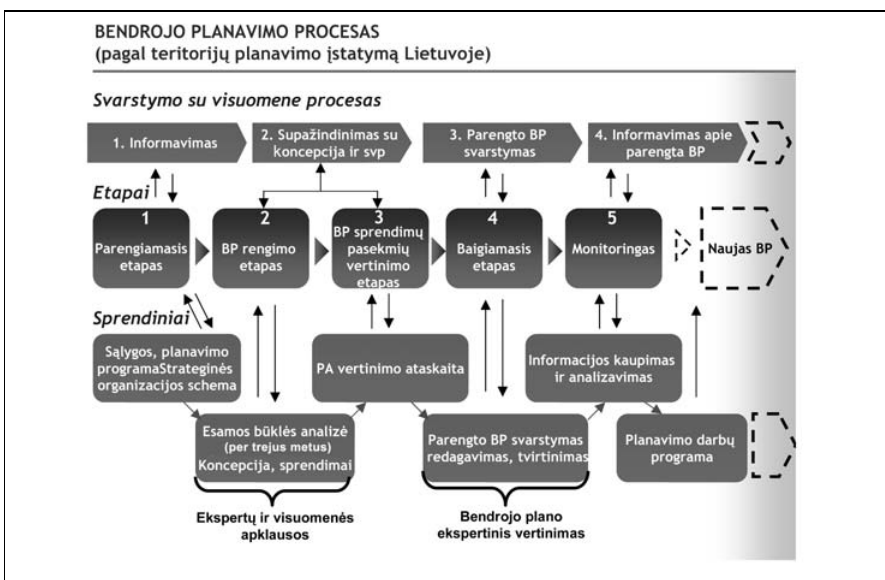
Fig 4. Harmonisation of the stages of preparation of Vilnius master plan with public discussion process and organisation of citizens and experts’